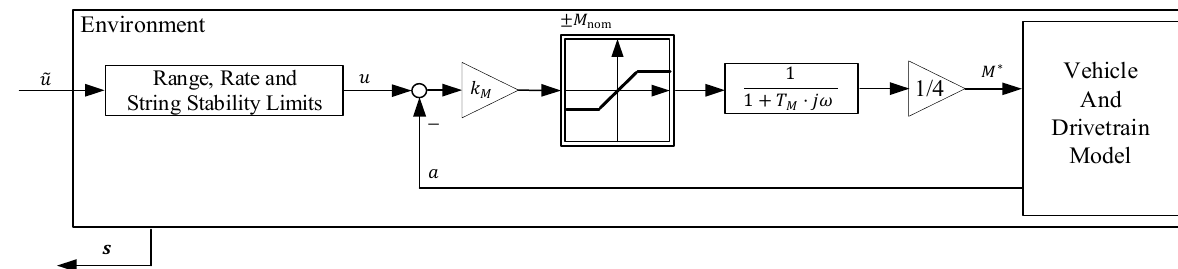
Figure 2. Block diagram of the environment.